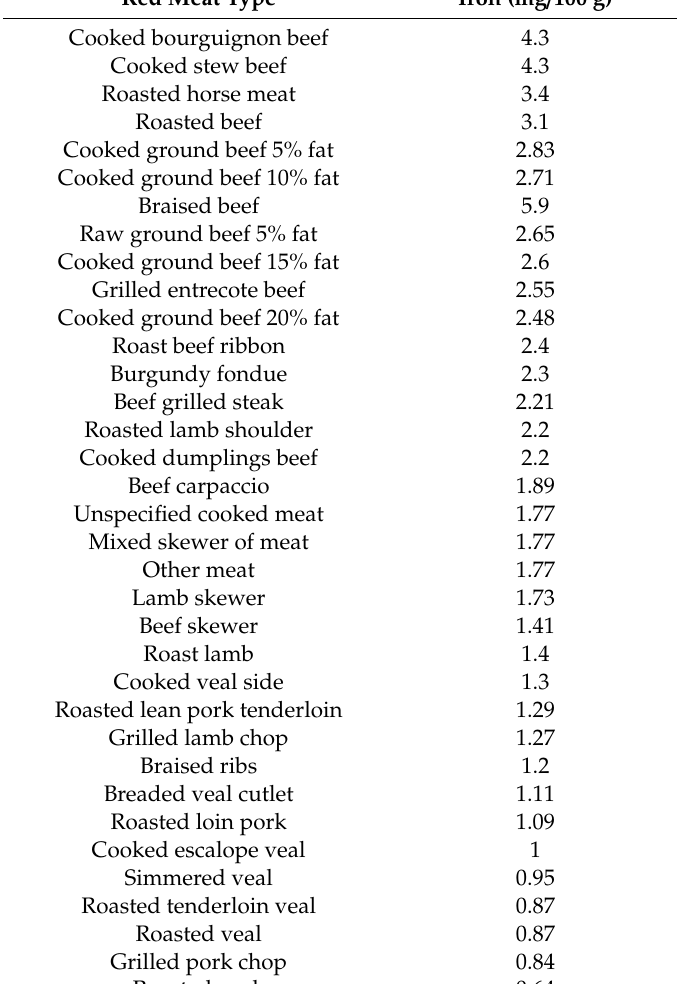
Table A3. Quantities of iron in di ff erent types of red